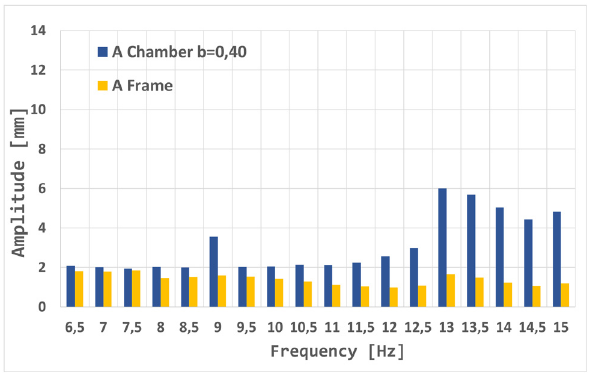
Figure 7: Quasi steady start up. Accelerations of the chamber and drive frame for the chamber fi lling degree equal to 0.80.